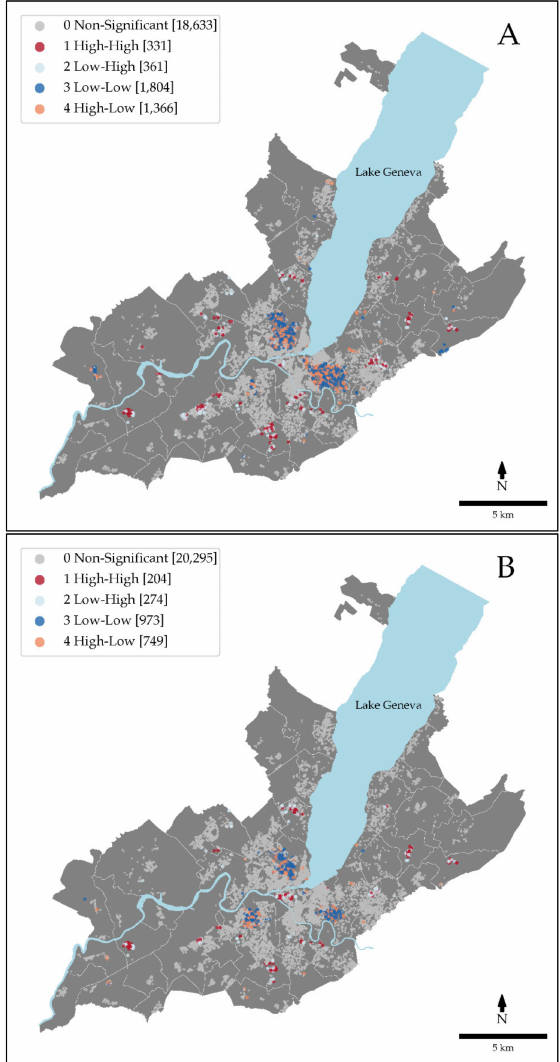
Figure 1. Local spatial clustering of Na:K ratio. Local Moran’s I spatial clusters of the Na:K ratio ( A ) unadjusted and ( B ) adjusted for socio-demographic and food environment characteristics using a geographically weighted regression (GWR model 3). The dark red markers (1 High-High) correspond to the individuals with a high Na:K ratio surrounded by individuals with a high Na:K ratio. The light blue markers (2 Low-High) correspond to individuals with a low Na:K ratio surrounded by individuals with a high Na:K ratio. The dark blue markers (3 Low-Low) correspond to individuals with a low Na:K ratio surrounded by individuals with a low Na:K ratio. The light red markers (4 High-Low) correspond to individuals with a high Na:K ratio surrounded by individuals with a low Na:K ratio. Grey markers are not significant at α = 0.05. White lines correspond to municipality